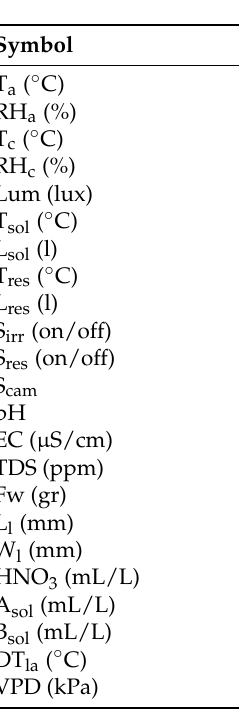
Table 1. Notation and nomenclature used for this